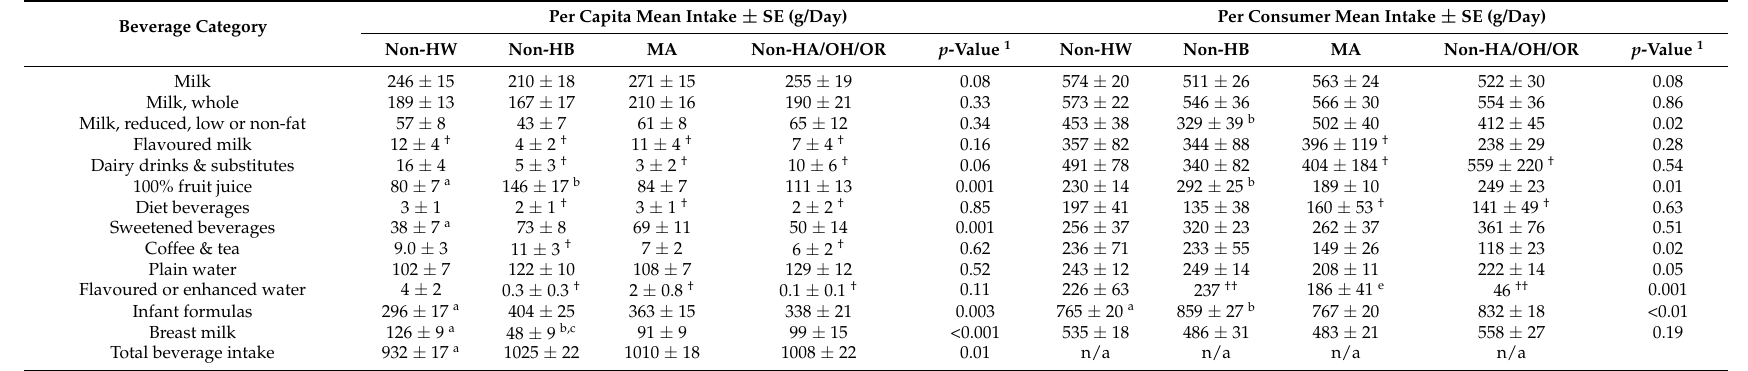
Table 3. Beverage consumption by race/ethnic group ( n =